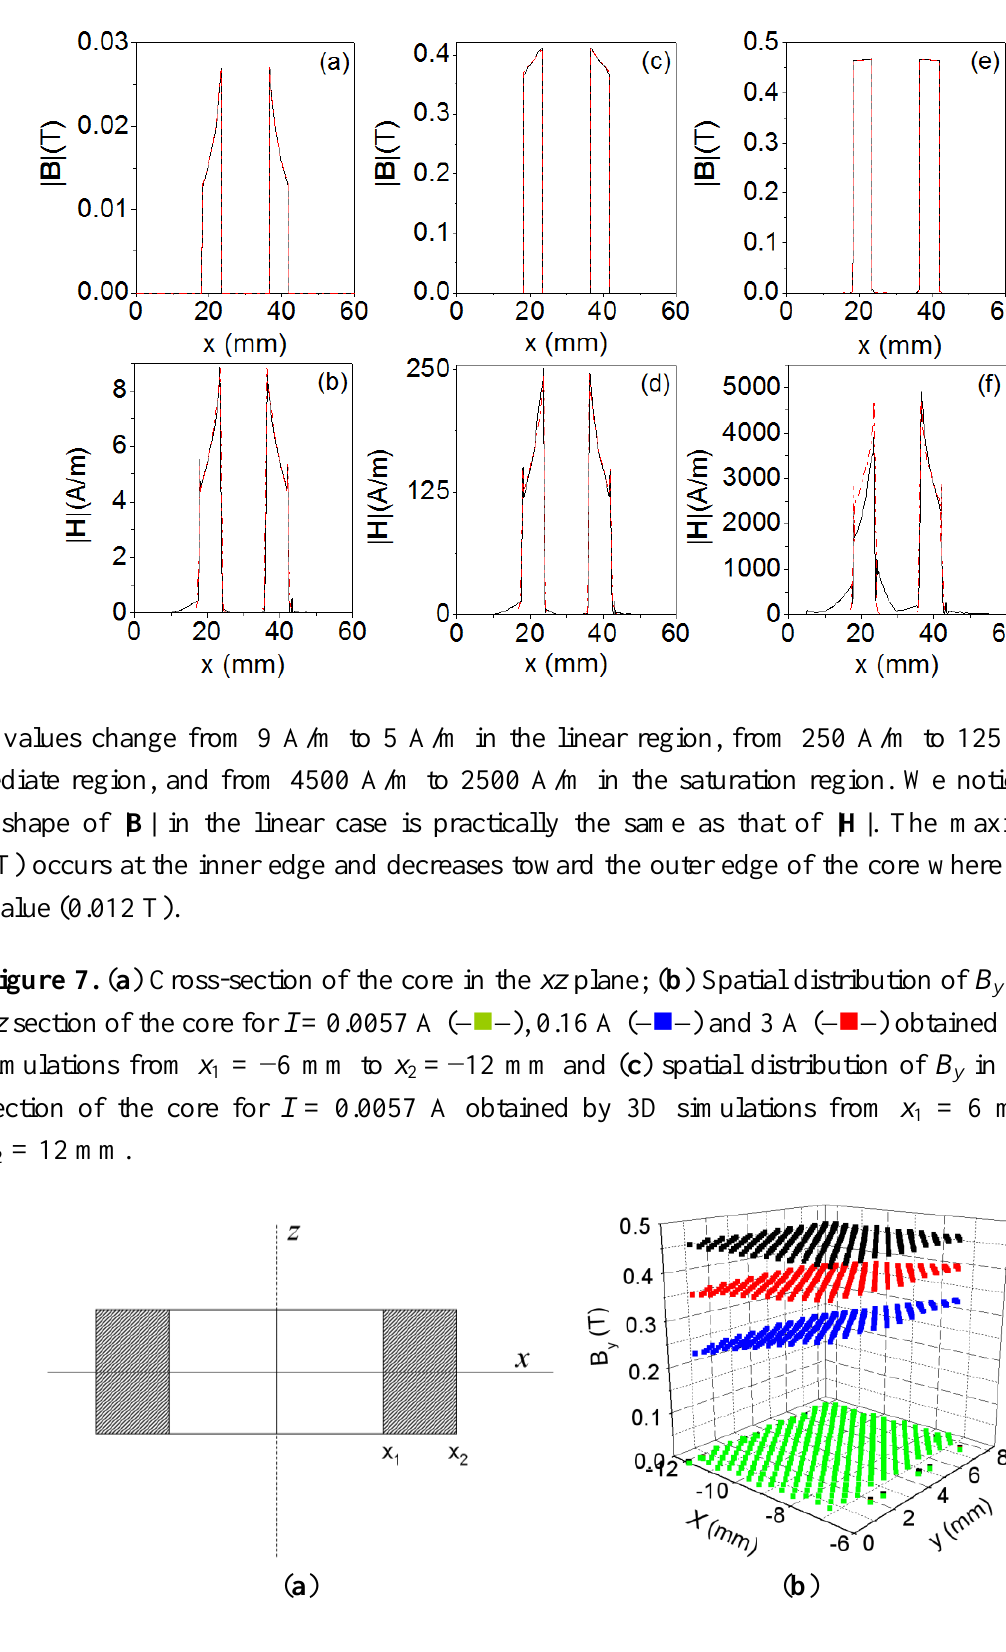
Figure 6. Moduli of the B and H magnetic fields as a function of the distance from the center of the inductor core ( x = 30 mm) obtained by 2D (red dashed line) and 3D (black solid line) simulations, for ( a , b ) I = 0.0057 A (linear region); ( c , d ) I = 0.16 A (intermediate region); ( e , f ) I = 3 A (saturation region).